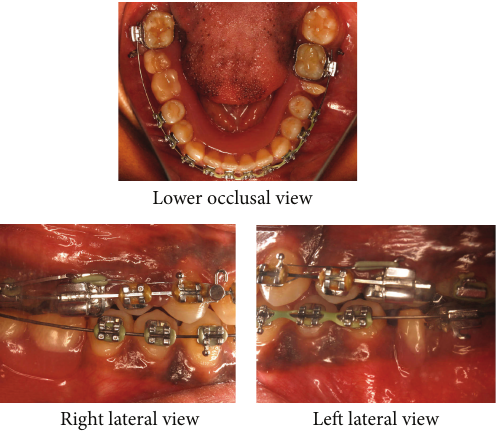
Figure 1: Pretreatment extraoral photographs.